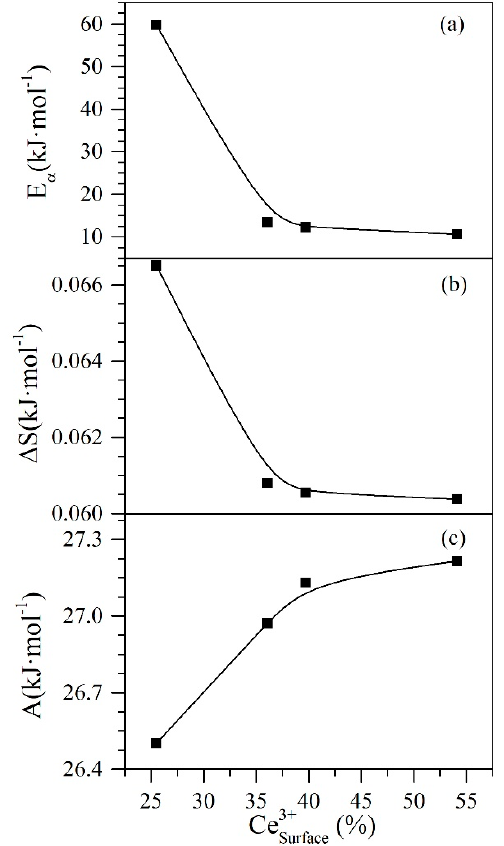
Figure 11. Catalytic e ff ect of Ce 3 + ions on ( a ) activation energy, ( b ) entropy and ( c ) Polanyi’s adsorption potential for n -C 7 asphaltene adsorption onto CeNi0.89Pd1.1 nanoparticles catalytic steam decomposition through regeneration catalytic cycles 1, 2, 4 and 9.